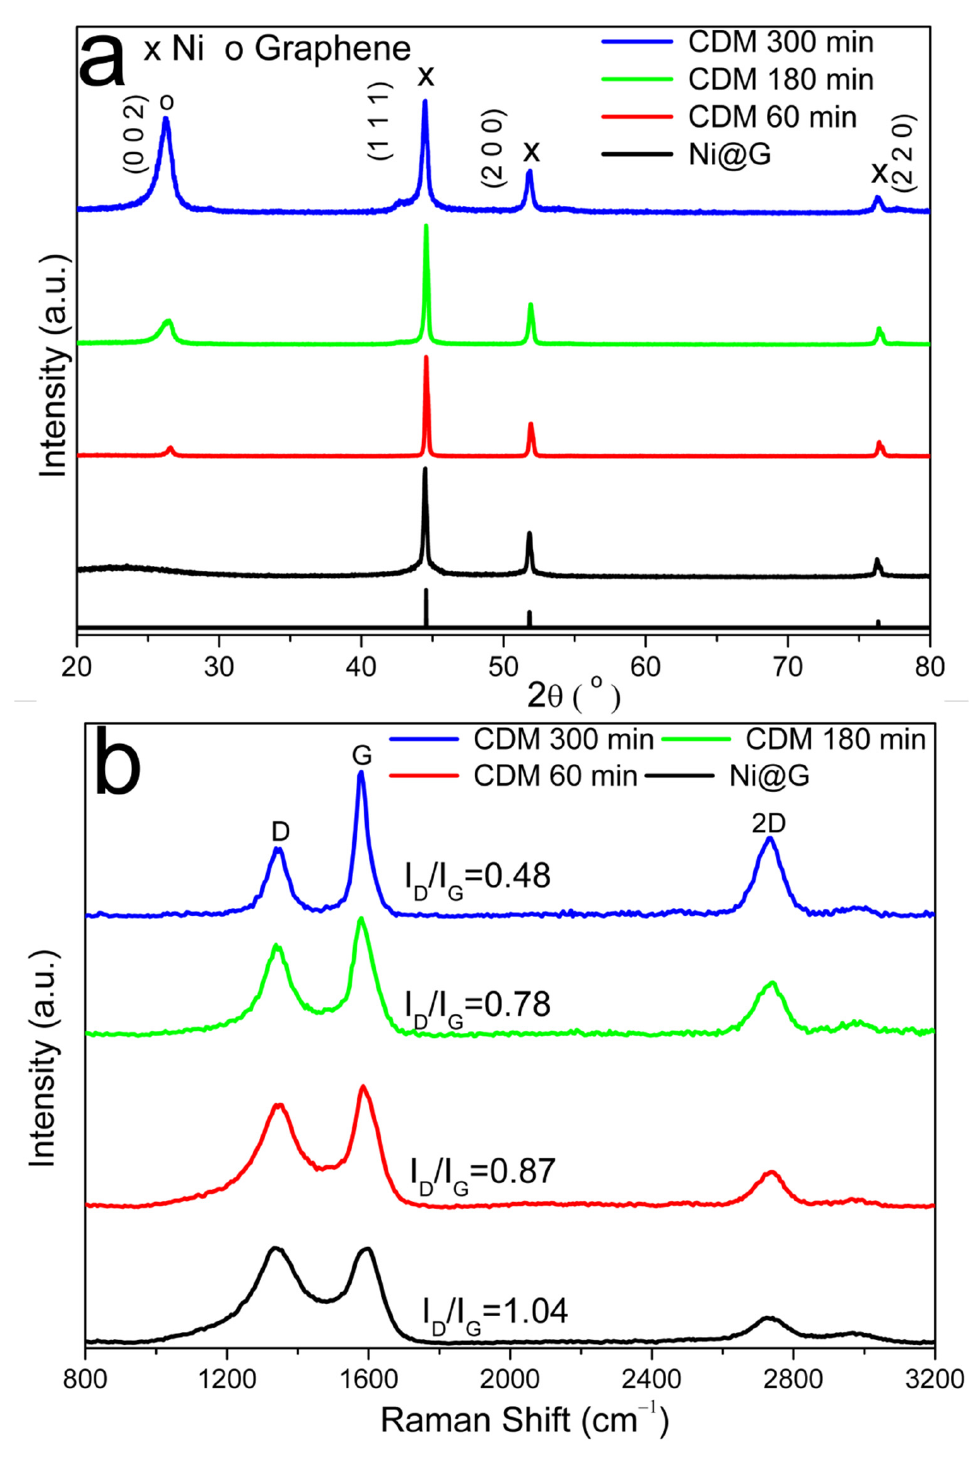
Figure 11. XRD patterns ( a ) and Raman spectra ( b ) after CDM reaction at 800 °C with different reaction time.